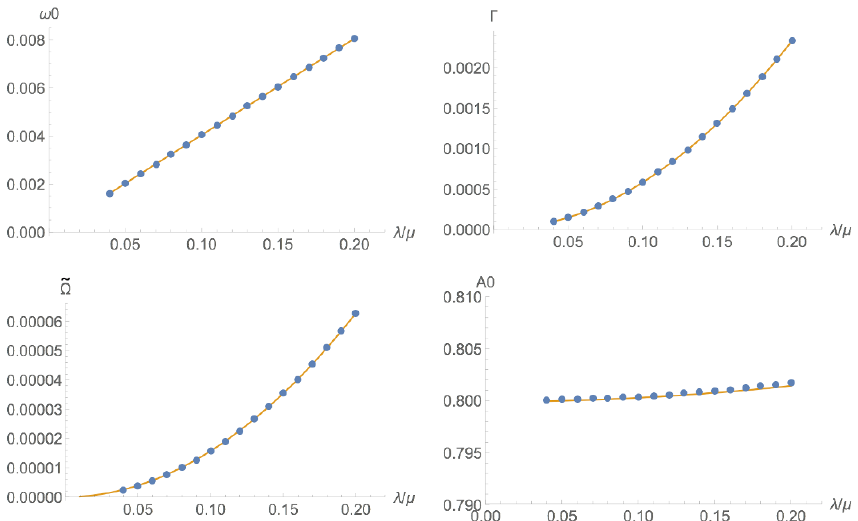
Figure 13 . Fitting parameters of the model (6.3) for pinned CDW, describing the pinned spon- taneous data (2.11) as function of (cid:21) . The data points denote the (cid:12)t parameters extracted from (cid:27) ( ! ), while the solid lines represent di(cid:11)erent cross-checks. In the case of (cid:0), ! 0 and (cid:10) these are the computation of the QNMs combined with the extraction of (cid:27) ( (cid:0) iw ). The solid line in A 0 was obtained from the thermodynamical quantities on the right hand side of (6.3).